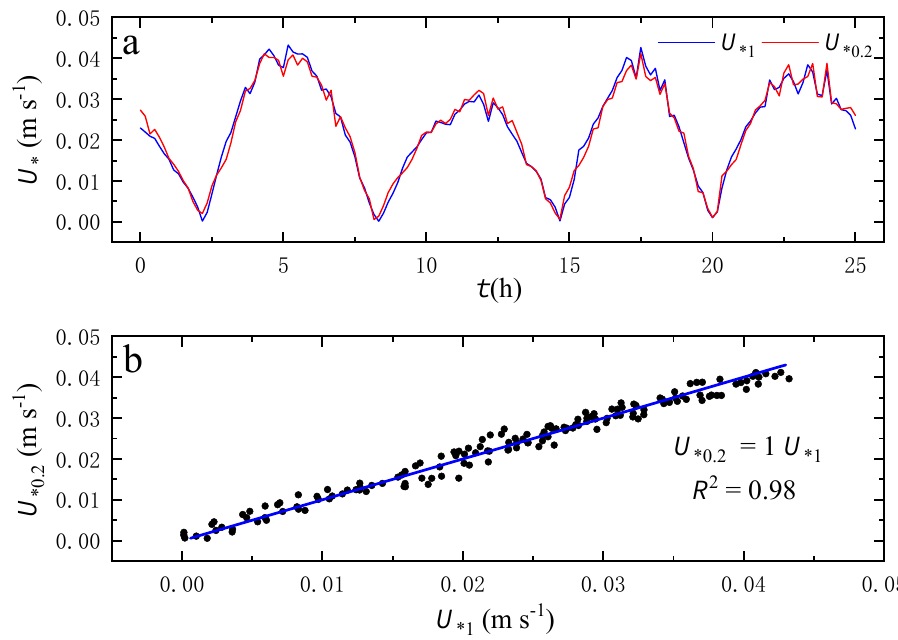
Figure 4. Friction velocity ( U * ) estimated from the log profile (LP) method. ( a ) Time series of friction velocity U *0.2 and U *1 , which are calculated by U 0.2 and U 1 based on Equation (5), respectively. ( b ) Relationship between U *1 and U *0.2 .